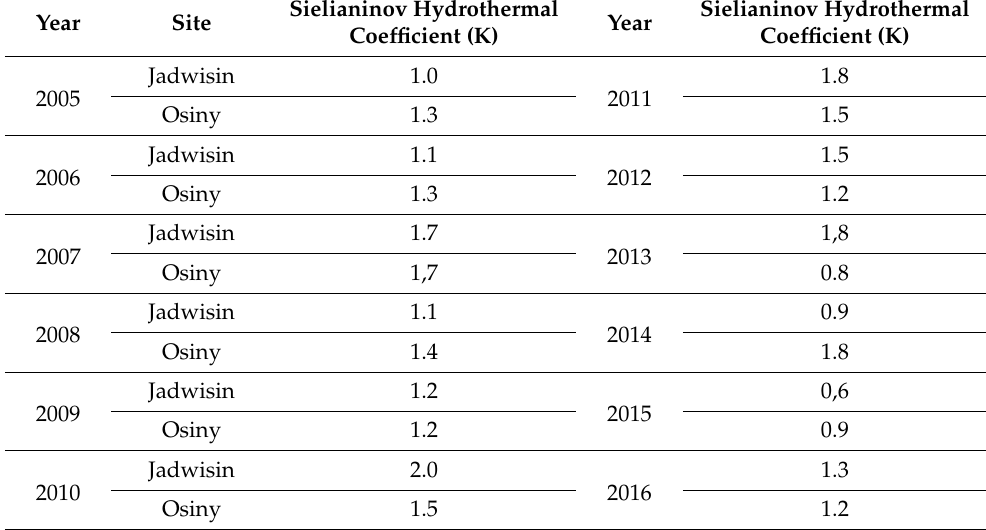
Table 1. The vegetation period conditions expressed by the Sielianinov hydrothermal coefficient in the years of research for Jadwisin and Osiny,